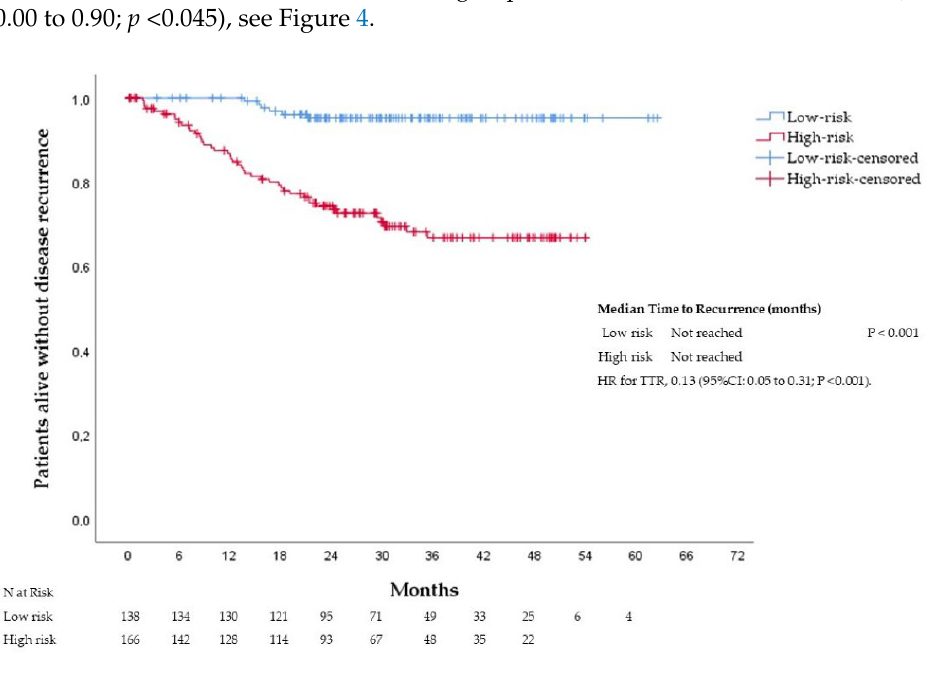
Figure 3. Time to recurrence according to risk groups (low-risk vs. high-risk) in the training cohort. HR, hazard ratio; CI, confidence interval.